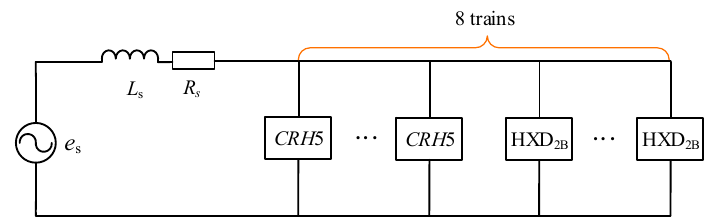
Figure 8. Schematic of the computer model built using Matlab/Simulink.